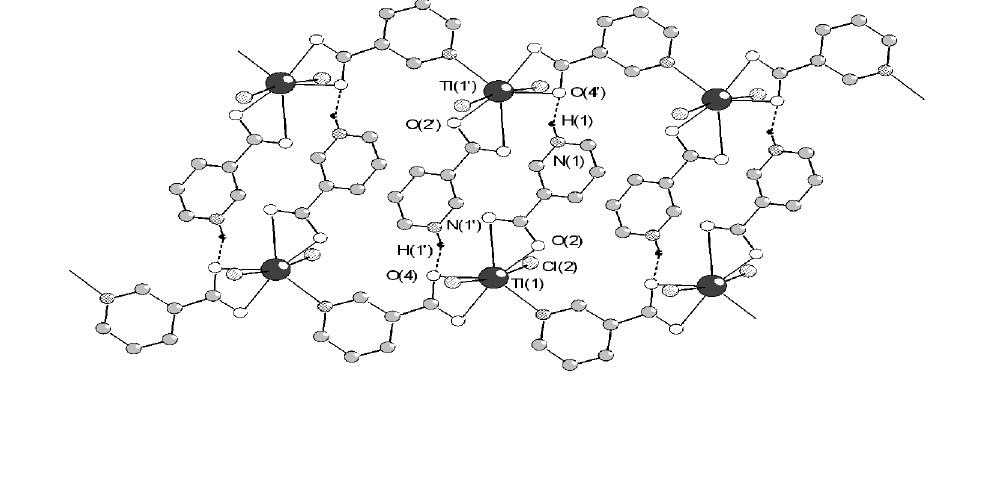
Fig. 3 Inter-chain hydrogen bonding in 2